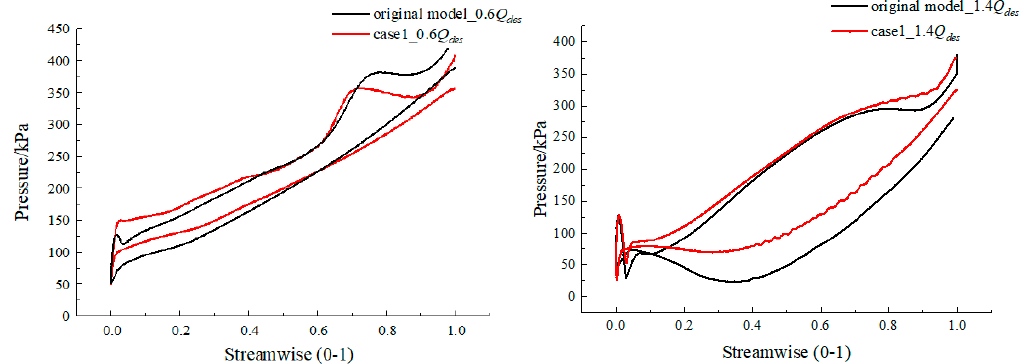
Figure 13. Variation of the blade load with streamwise at 0.6 Q ( left ) and at 1.4 Q ( right ).